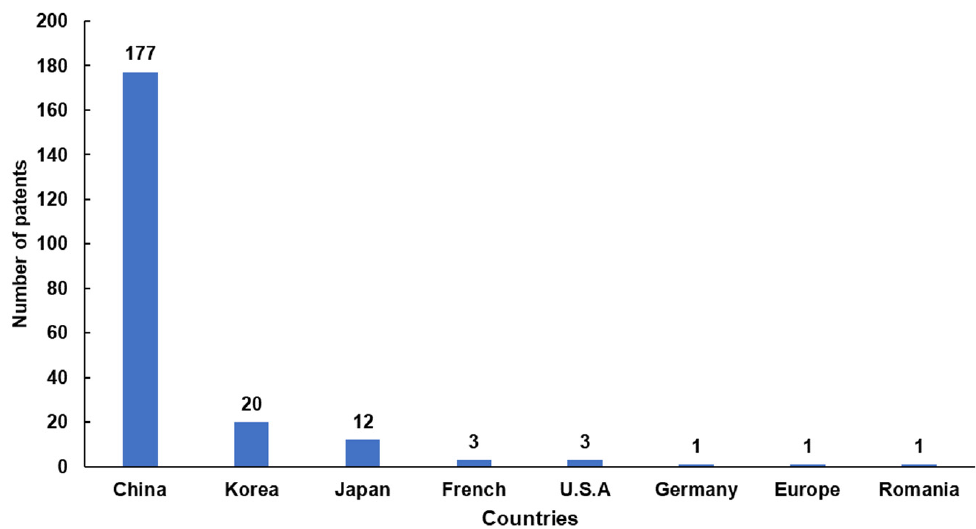
Figure 3. The number of applications for lily-related patents in different countries (2005–2021).